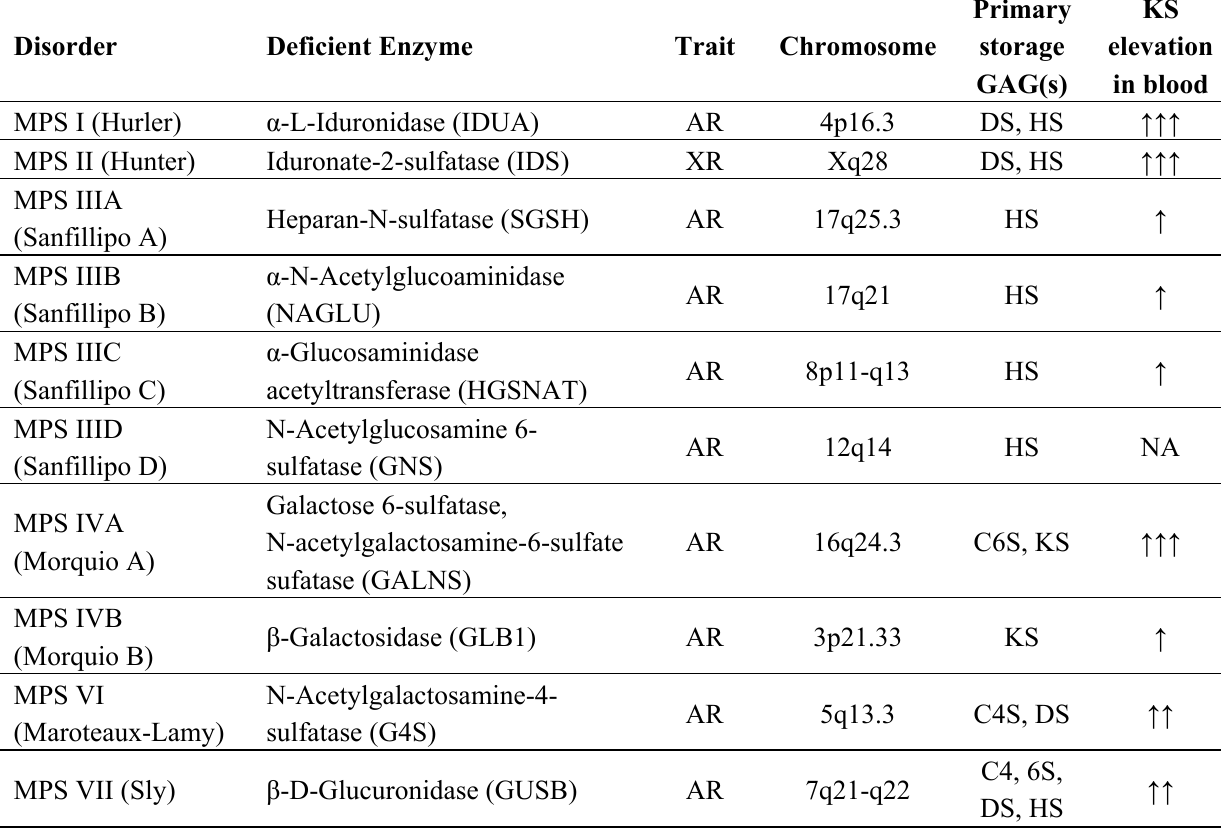
Table 1. Correlation between mucopolysaccharidoses and GAG